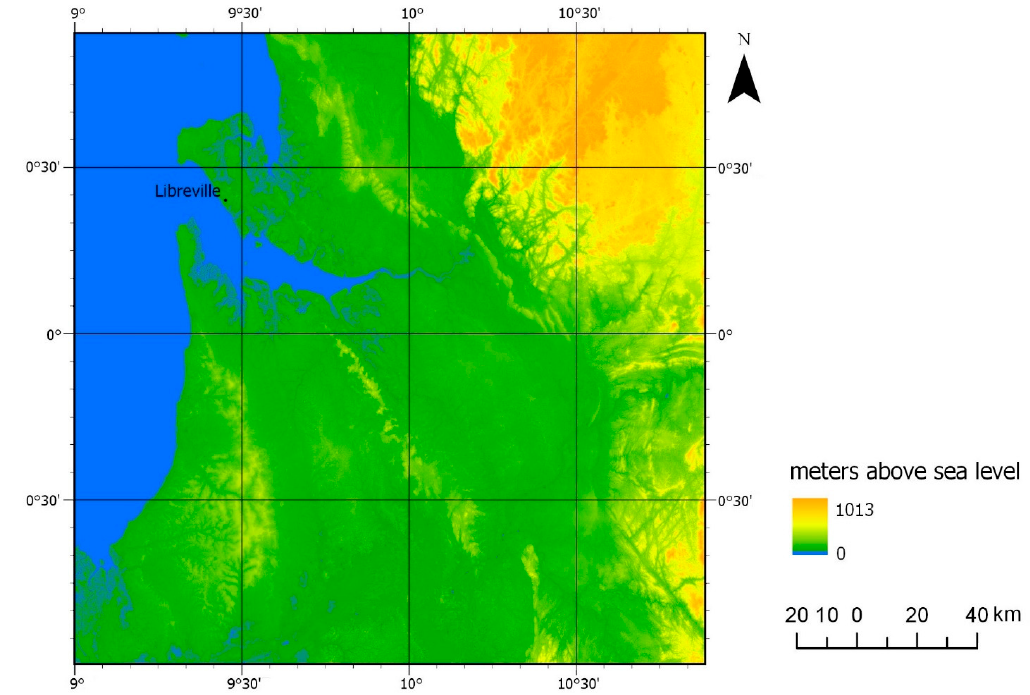
Figure 2. Shuttle Radar Topography Mission Digital Elevation Model (SRTM DEM) over the study area.